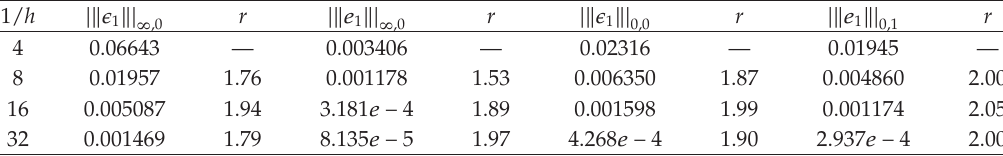
Table 1: Defect step approximation for λ (cid:9) 5 . 0.